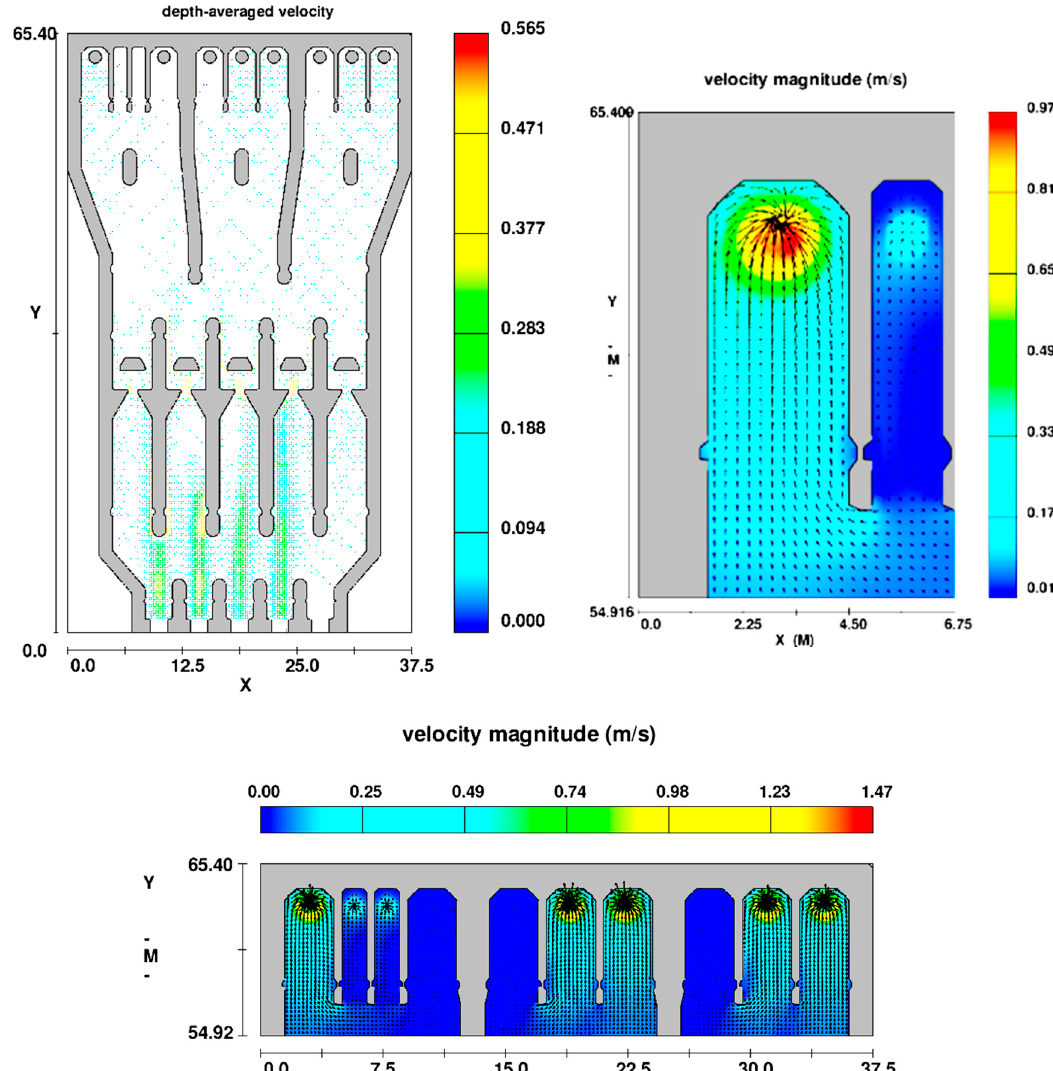
Figure 12. Field vector of velocity at the basin for scenario IV—3D model.